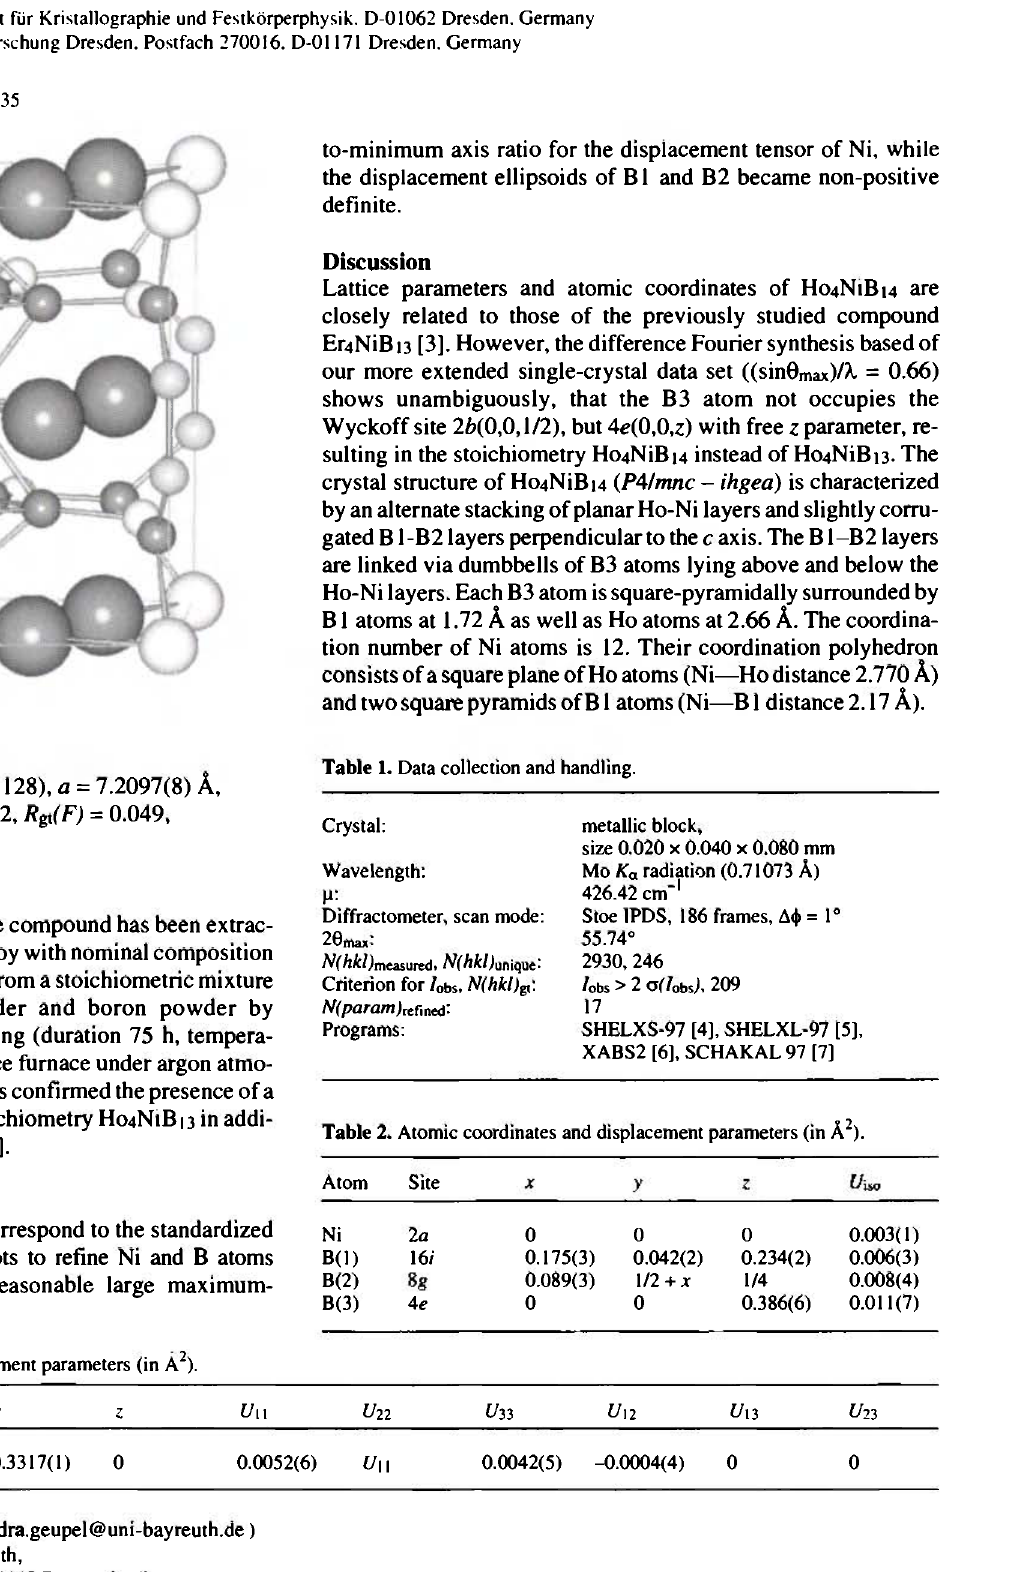
Table 3. Atomic coordinates and displacement parameters (in A 2